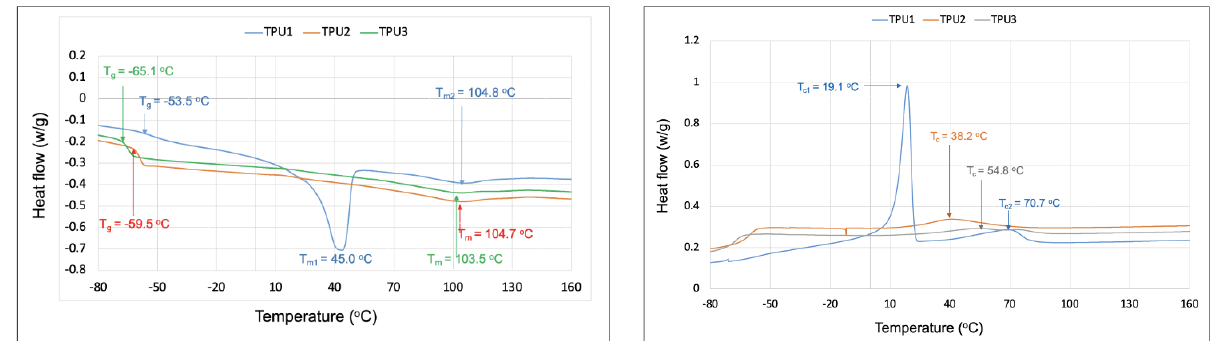
Table 4. Properties of thermoplastic polyurethanes.